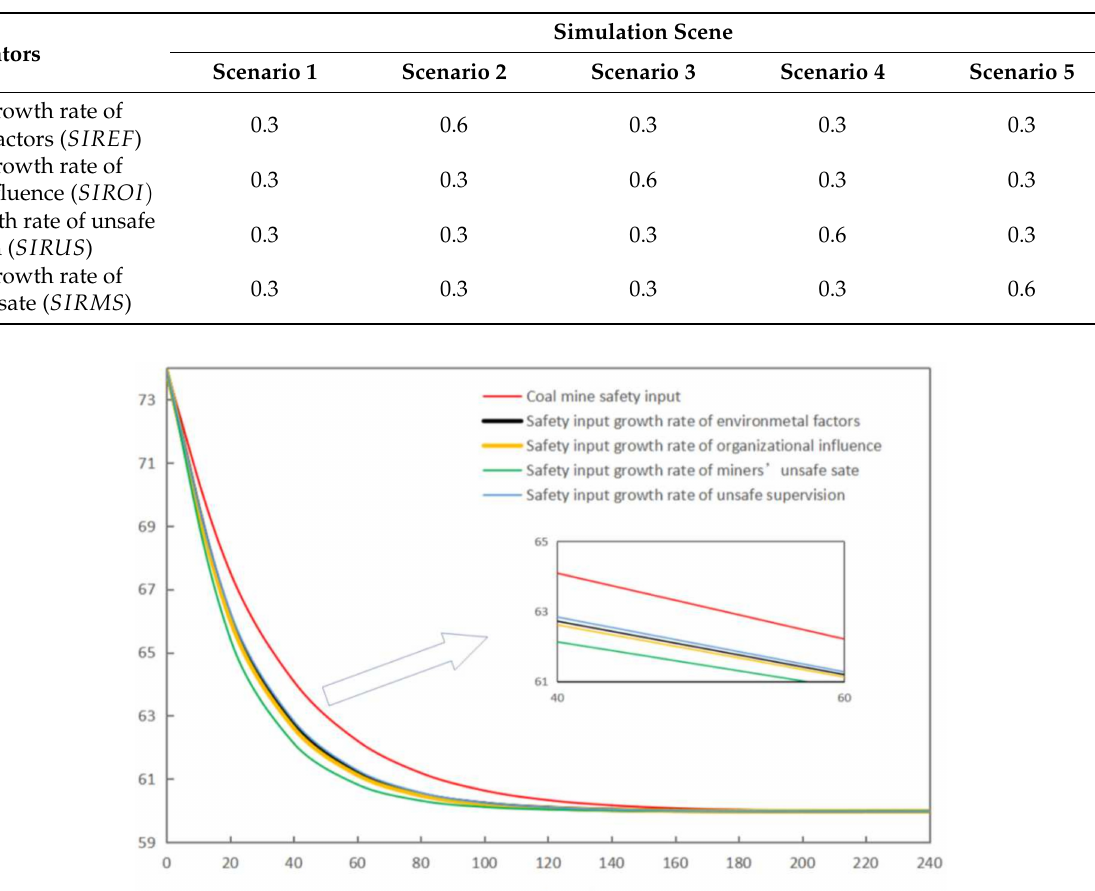
Table 10. Coal mine safety input scenarios for different subsystems.